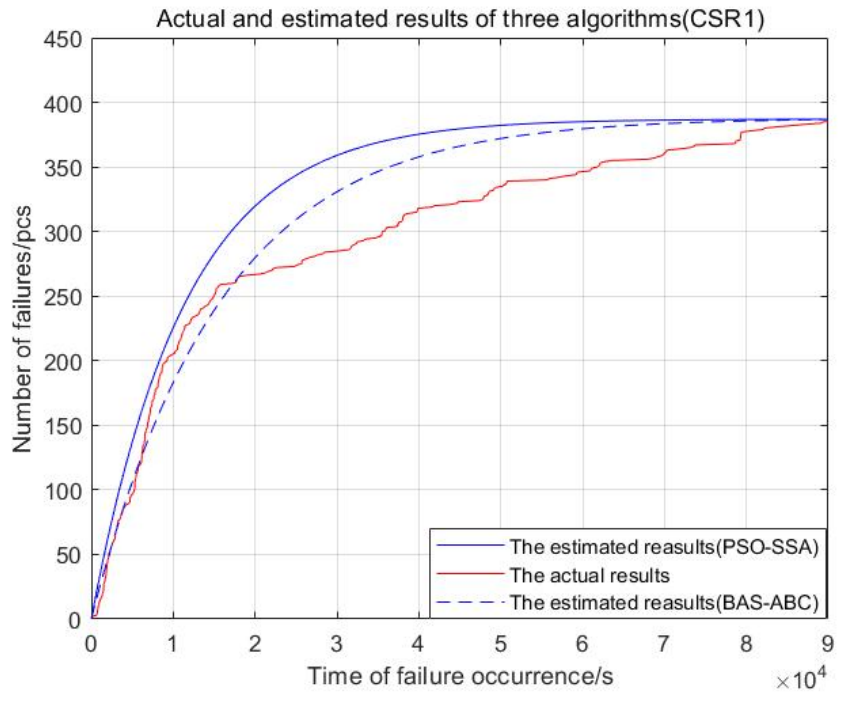
Figure 20. Actual and estimated results of two algorithms (CSR1).